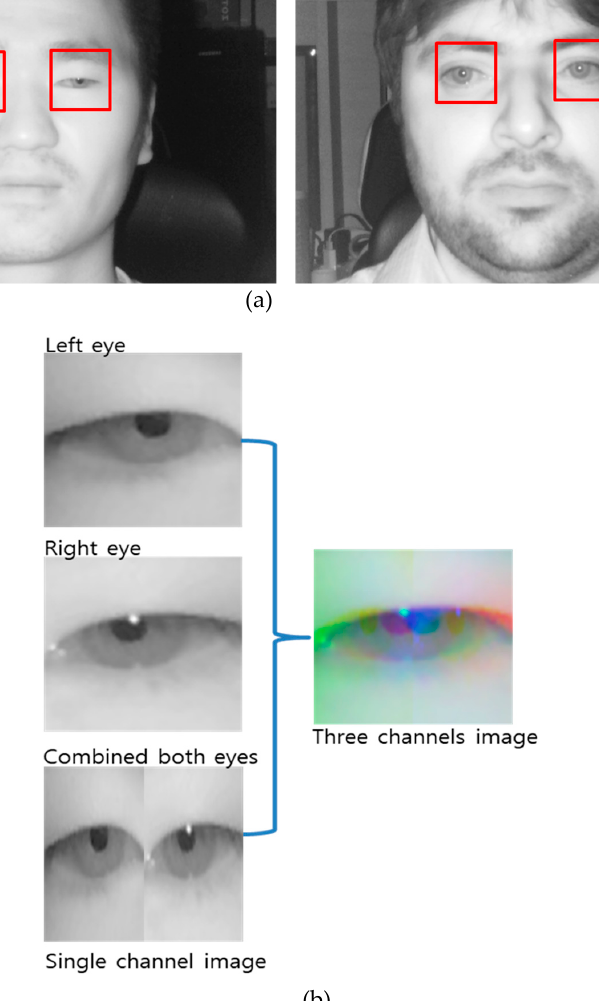
Figure 6 . Gaze change obtained by ( a ) Defining region of interest (ROI) on original image based on facial landmarks. ( b ) Three channel image obtained by combining left eye, right eye, and combined left and right eye.